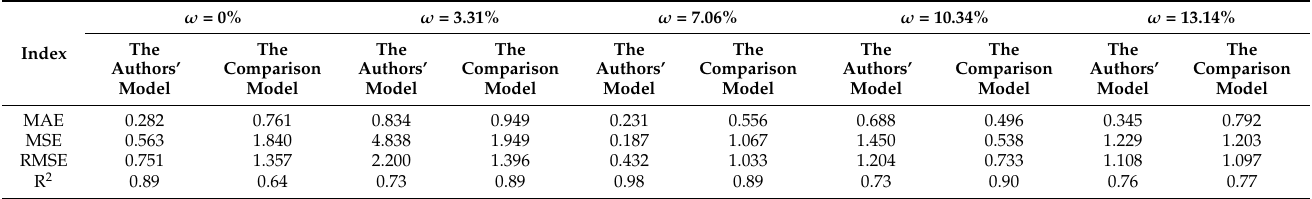
Table 4. The fitting effect evaluation index values of the two models based on the experimental data in test group 3.